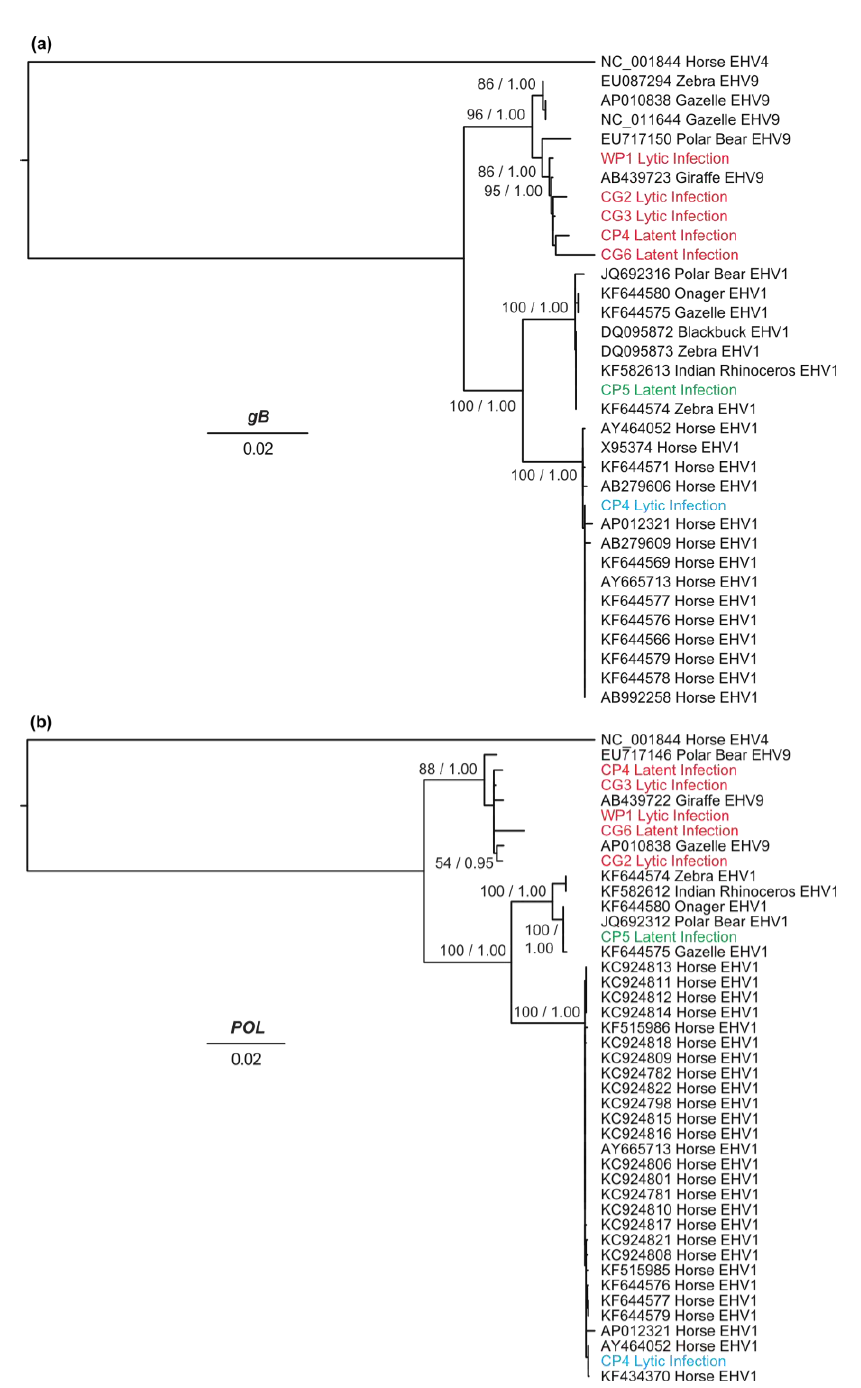
Figure 3. Phylogenetic trees inferred using maximum likelihood from nucleotide sequences of ( a ) gB and ( b ) Pol genes for the six zebras WP1, CG2, CG3 (Equine herpesvirus 9 (EHV-9) lytic infection), CP4 (Equine herpesvirus 1 (EHV-1) lytic and EHV-9 latent infection), CP5, and CG6 (EHV-1 and EHV-9 latent infection, respectively) and other equine herpesviruses. Reference sequences are indicated by GenBank accession number, species from which the sequence was isolated, and viral strain. The novel EHV-9 sequences are in red , the novel EHV-1-horse like zebra sequence is in blue , and the novel zebra-EHV-1 sequence is in green . The trees are shown with branches lengths scaled to nucleotide substitutions per site. Selected nodes are labeled with maximum-likelihood bootstrap support values and posterior probabilities, separated by a slash “/”.